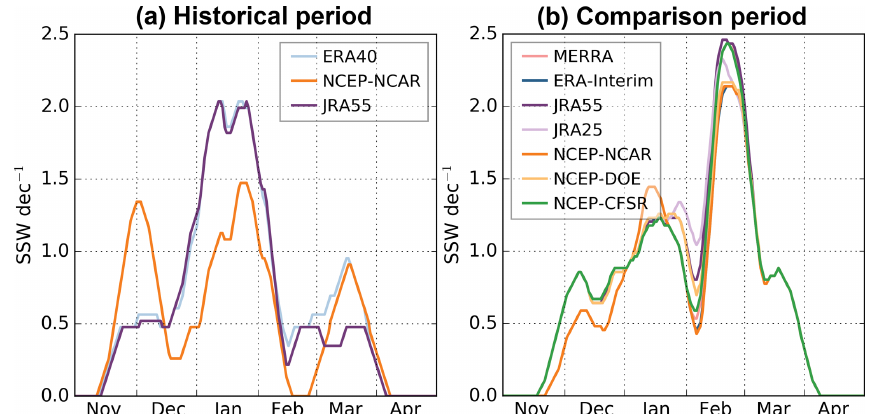
Figure 2. SSW total frequency distribution within ± 10d periods from the date displayed in the x axis for (a) the historical period (1958– 1978) and (b) the comparison period (1979–2012). Time series are smoothed with a 10-day running